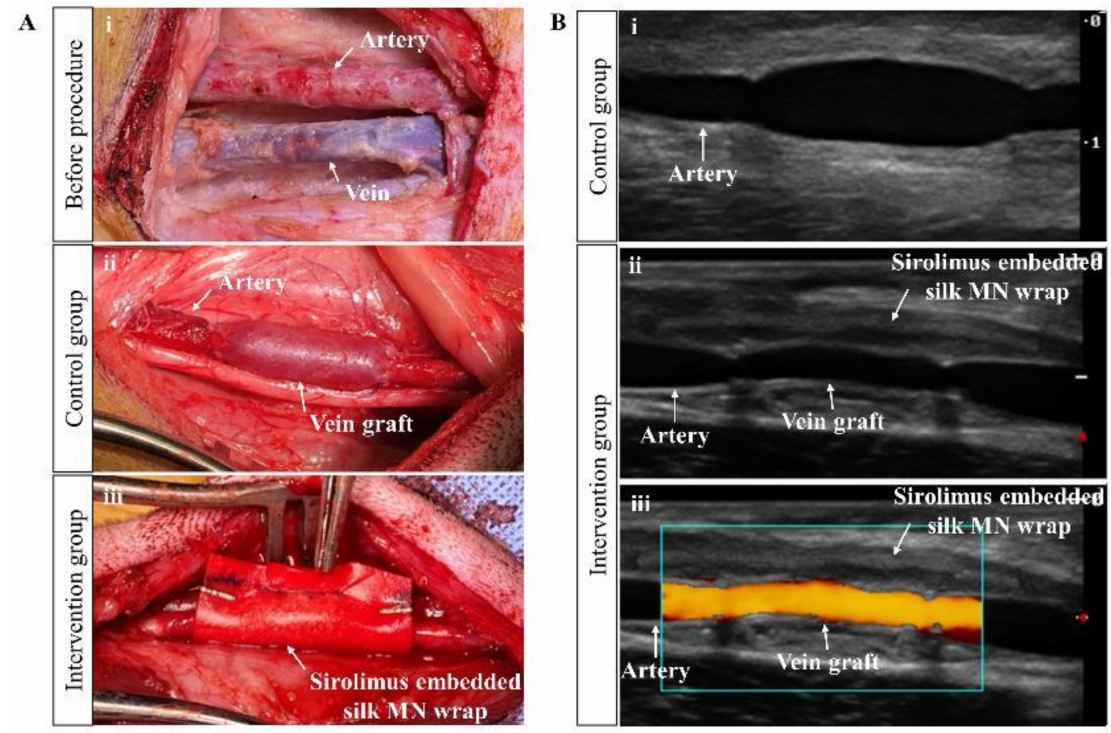
Figure 10. In vivo surgical procedures and ultrasonographic images. ( A ) Representative intra- operative images of (i) preimplantation, (ii) the control group, and (iii) the intervention group. ( B ) Representative postoperative ultrasonographic images in (i) the control group, (ii) the intervention group, and (iii) Doppler image of the vein graft in the intervention group. MN,